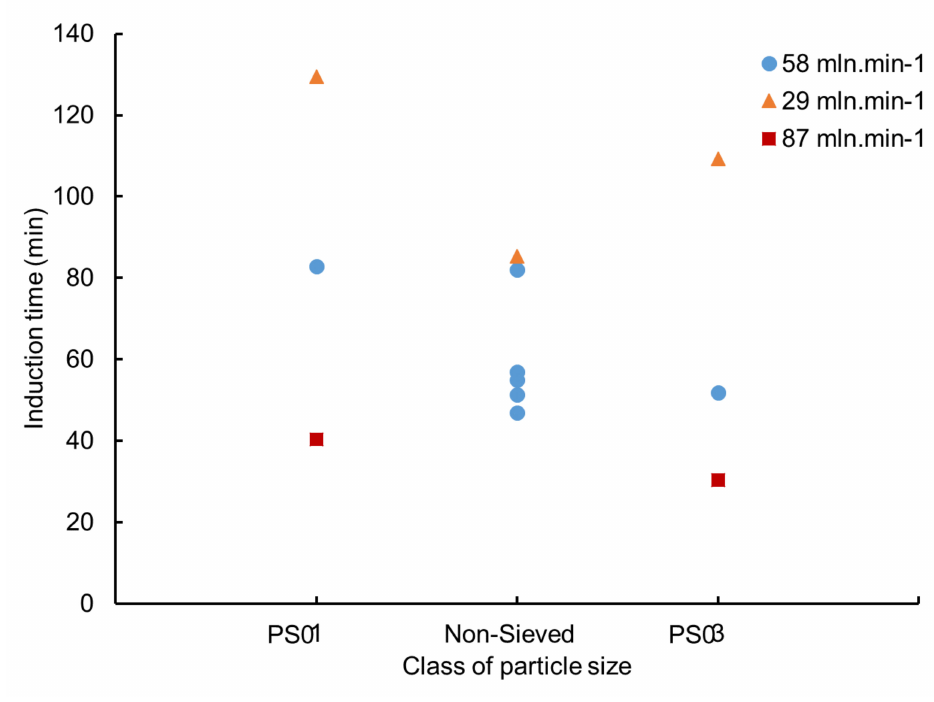
Figure 9. Induction time as a function of particle size for a water saturation around